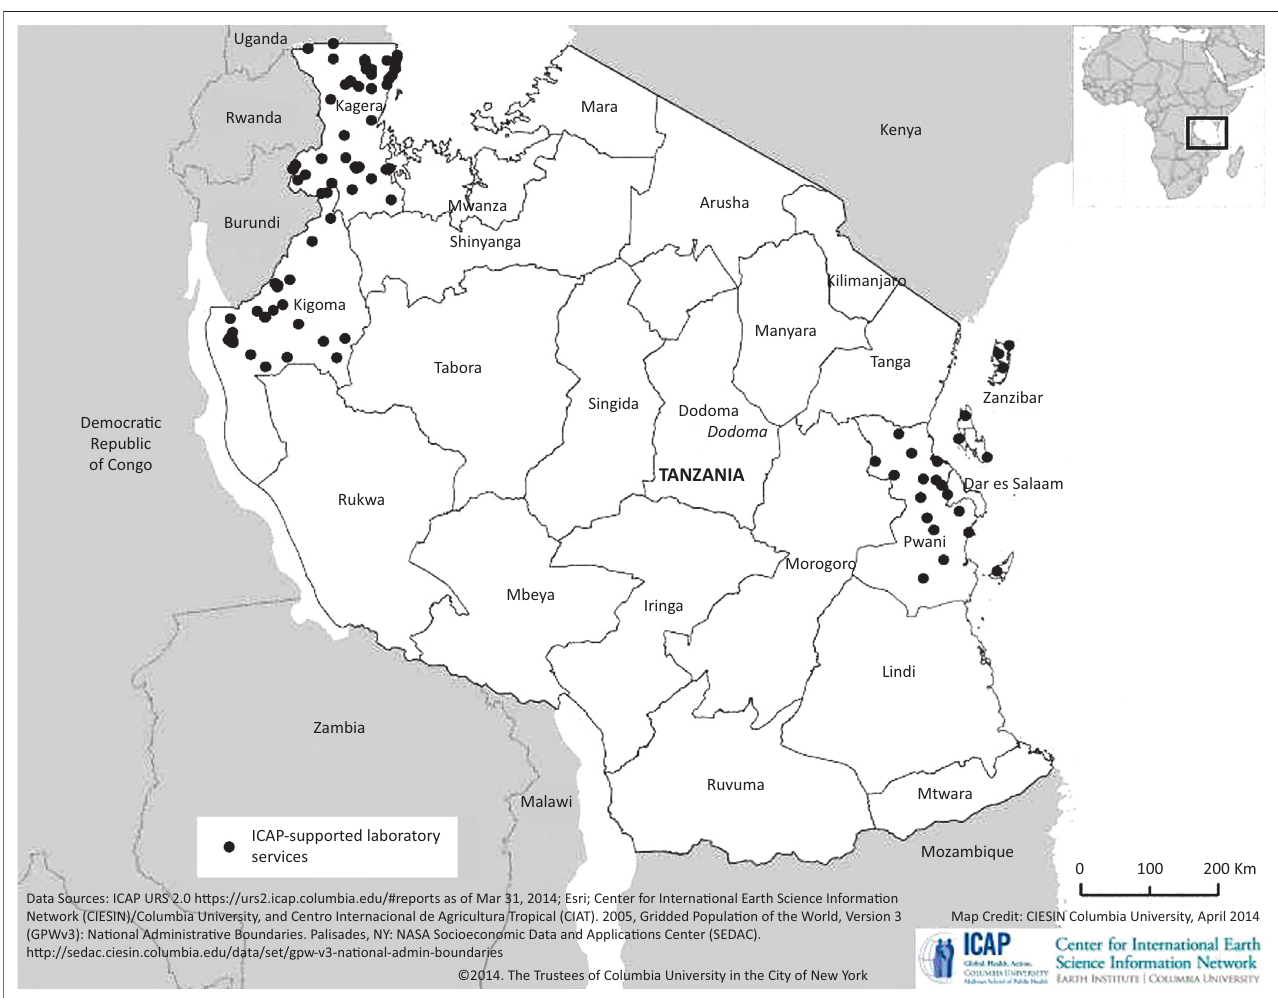
FIGURE 1: Location of laboratories in Tanzania receiving PEPFAR support from ICAP during 2009 and 2011 ( N = 94 laboratories in 2009 and 101 in